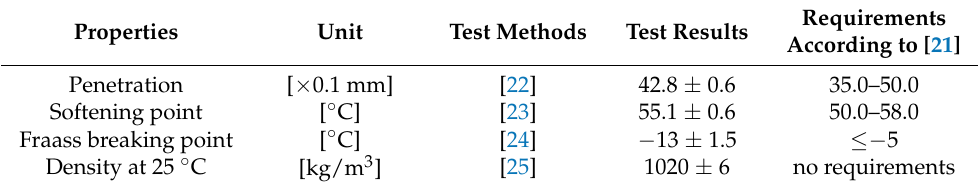
Table 1. Basic properties of the 35/50 penetration grade bitumen.